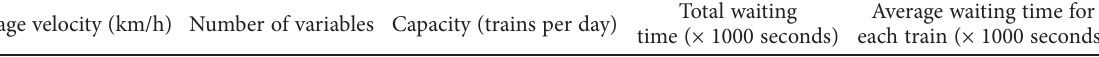
Table 2. Line capacity evaluation